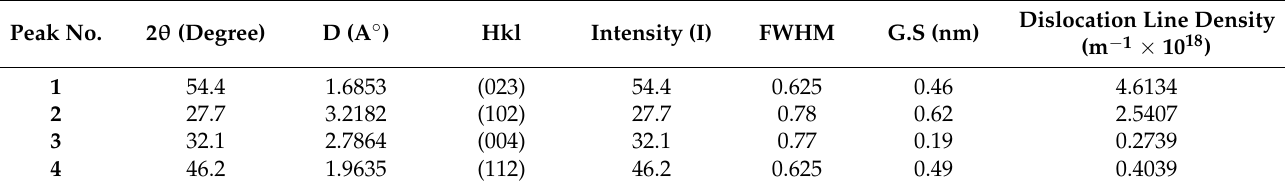
Table 1. The XRD data of pure AlSb-deposited thin films recorded at 1.5 h.